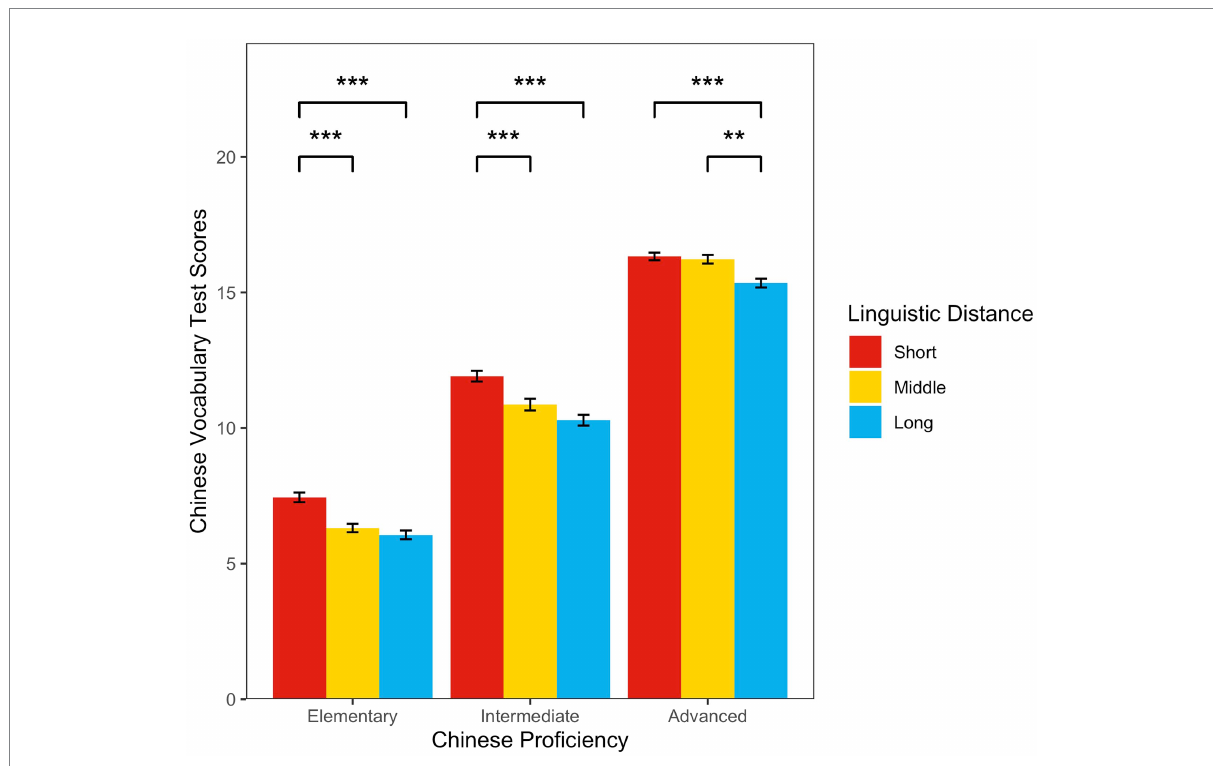
FIGURE 4 The relationship between Chinese proficiency, linguistic distance, and Chinese vocabulary test